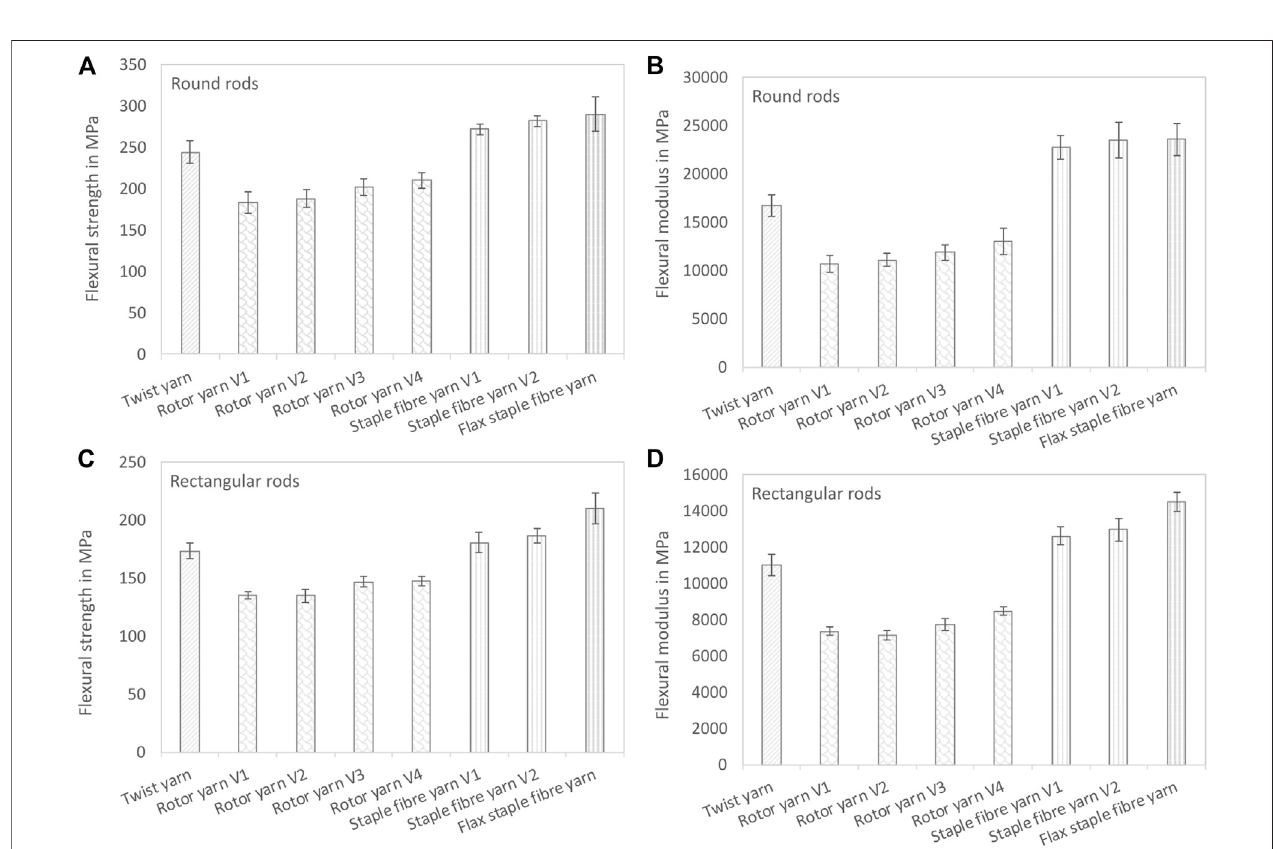
FIGURE 6 | Flexural strength and fl exural modulus (mean value ± standard deviation) of pultruded round rods with a fi bre volume fraction of 40% (A,B) and rectangular rods with a fi bre volume fraction of 30% (C,D) .